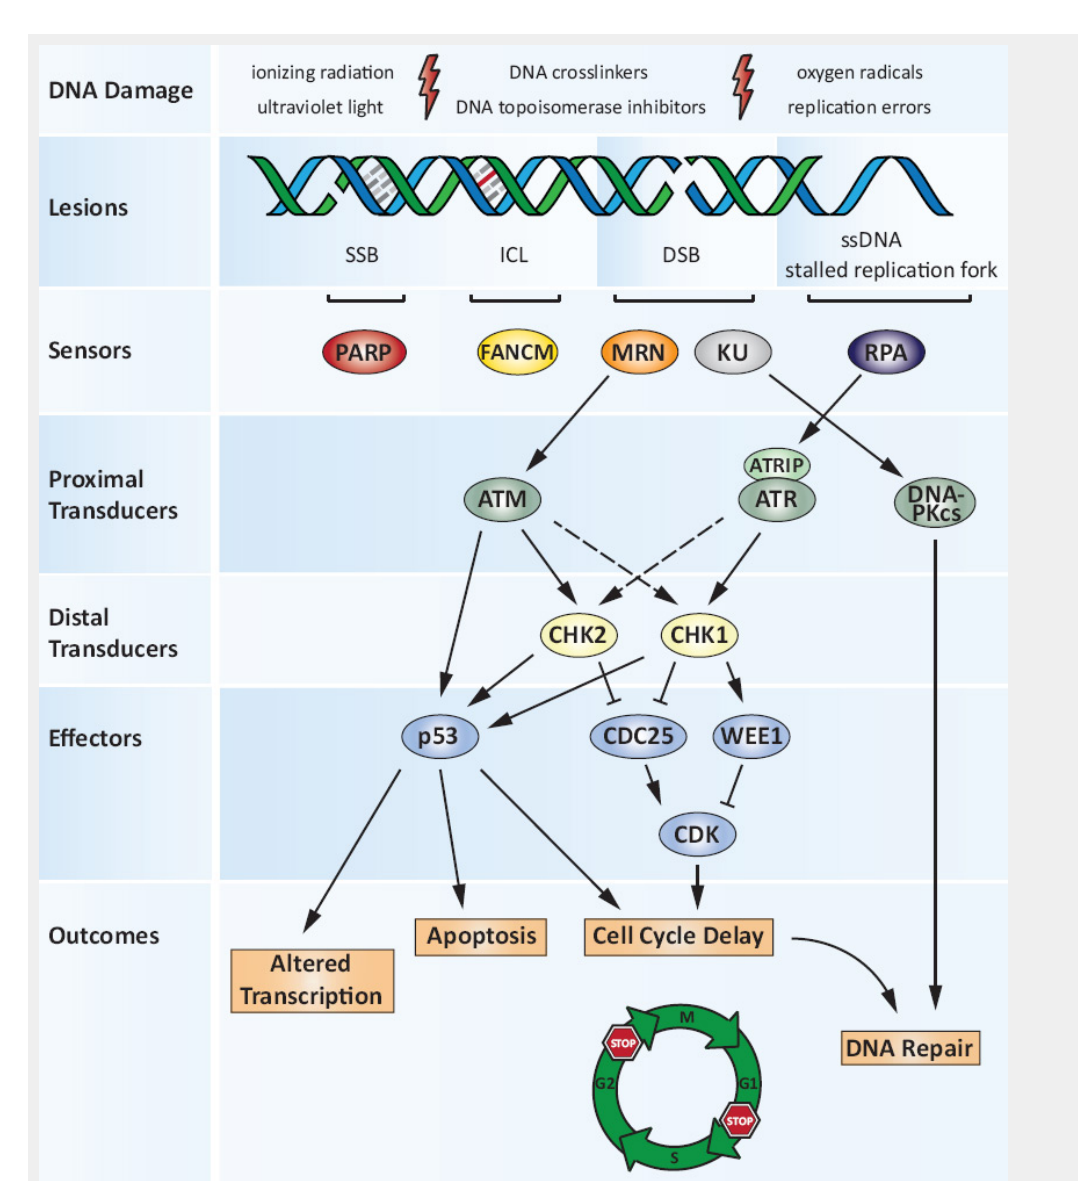
The DNA damage response. Exogenous and endogenous DNA damaging agents generate various types of lesions including DNA single- and double-strand breaks (SSBs and DSBs). The multifunctional MRN complex detects DSBs, while FANCM is required for the DNA interstrand crosslink (ICL)-induced checkpoint response. PARP predominantly acts as a SSB sensor protein. RPA binds to regions of single-stranded DNA (ssDNA) that are exposed at stalled replication forks or after DSB resection. MRN and RPA mediate the recruitment of ATM and ATR-ATRIP, respectively, and the subsequent activation of the respective pathways, coordinating cell-cycle checkpoints, DNA repair and apoptotic responses to DNA damage. The Ku70/Ku80 heterodimer (KU) competes with MRN for binding to DSBs. KU recruits DNA-PKcs to form the catalytically active DNA-PK holoenzyme which is a major component of the canonical NHEJ machinery during DSB repair. MRN on the other hand initiates HR (see also fig. 2). Once activated, the DNA damage signalling cascade extends through multiple phosphorylation events primarily via the cell-cycle checkpoint kinases CHK1 and CHK2. Their signals converge on downstream effectors such as the tumour suppressor protein p53 or the CDC25 protein phosphatase and WEE1 tyrosine kinase. As a result, CDK activity is inhibited, delaying cell cycle progression from G1 to S (the G1/S checkpoint) or from G2 to M phase (the G2/M checkpoint). The DNA damage response (DDR) thus orchestrates a variety of cellular outcomes: the transcriptional programme of the damaged cell is altered and the cell cycle is transiently arrested, thereby facilitating repair of the DNA lesions. In situations where DNA damage is too severe and cannot be repaired, the DDR triggers apoptosis or senescence. ADP = adenosine diphosphate; ATM = ataxia telangiectasia mutated protein; ATR = ATM- and Rad3-related; ATRIP = ATR-interacting protein; CDK = cyclin-dependant kinase; DNA = deoxyribonucleic acid; DNA-PK = DNA-dependant protein kinase; DNA-PKcs = DNA-PK catalytic subunit; FANCM = Fanconi anaemia complementation group M; HR = homologous recombination; ICL = interstrand crosslink; MRN = MRE11-RAD50-NBS1 complex; NEHJ = nonhomologous end joining; PARP = poly(ADP-ribose) polymerase; RPA = replication protein